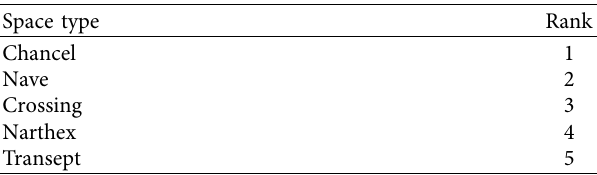
Table 11: Proposed priority hierarchy of space type for mainte- nance at Anglican churches in Malaysia.